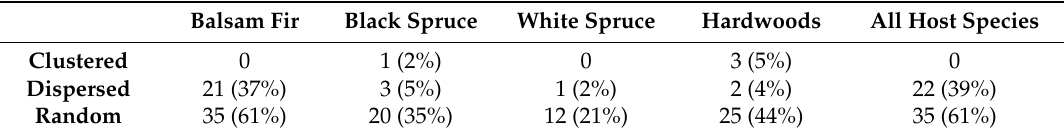
Table 2. Number and percentage of plots with clustered, dispersed, or random tree stem locations based on average nearest neighbor analyses ( α = 0.05), for balsam fir, black spruce, white spruce, hardwoods, and all host species per plot. Balsam Fir Black Spruce White Spruce